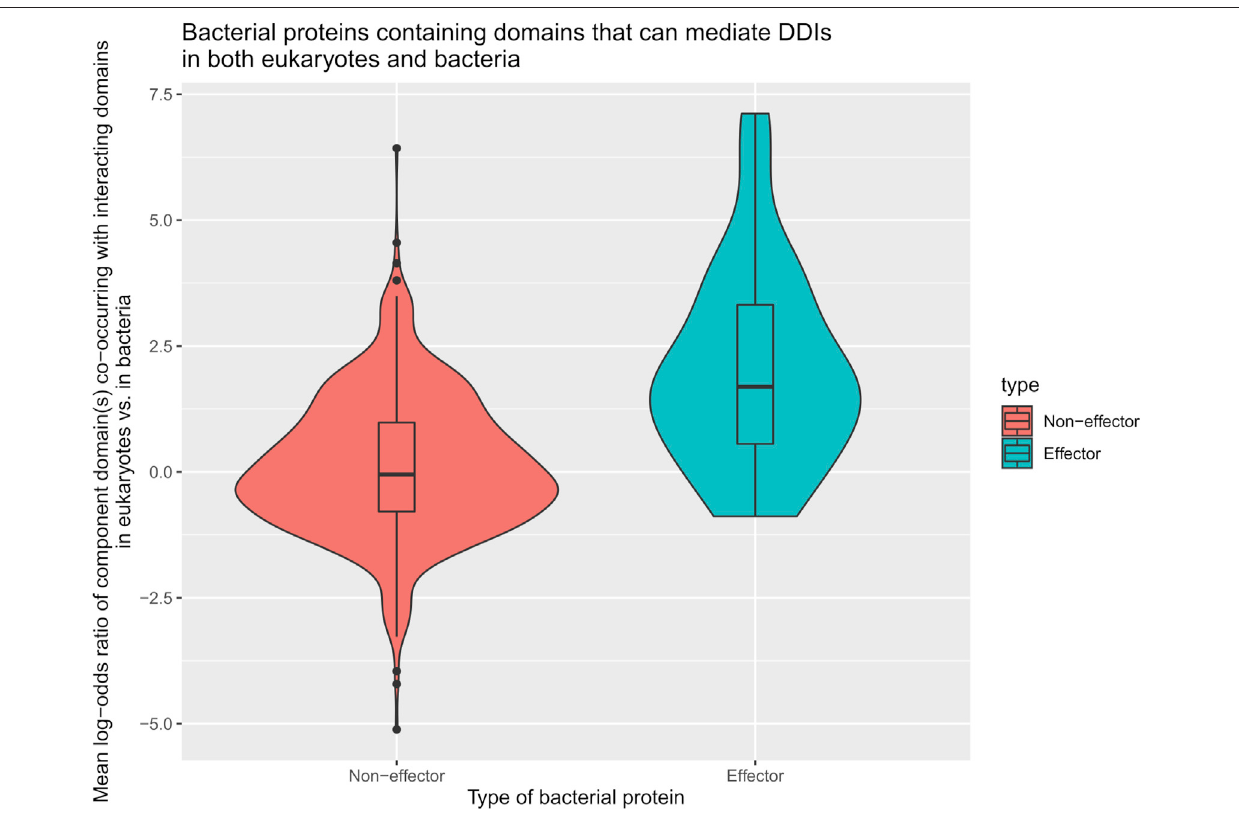
FIGURE 3 | Effectors are enriched for eukaryotic-like domains that mediate PPIs primarily in eukaryotes. Among pathogen proteins containing domains that have DDIpartnersinbotheukaryotesandbacteria,theaveragedomainineffectorsisseventimesaslikelyasthatinnon-effectorstoco-occurwithDDIpartnersineukaryotes